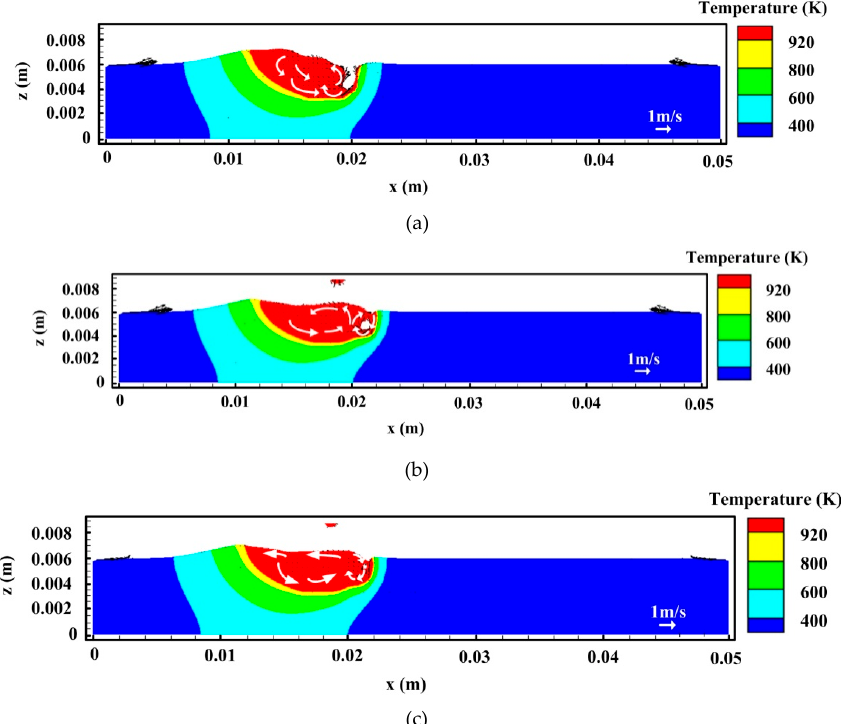
Figure 11. Temperature and velocity fields on the longitudinal section for I = 200 A: ( a ) t = 0.92 s, ( b ) t = 0.93 s, and ( c ) t = 0.94 s.